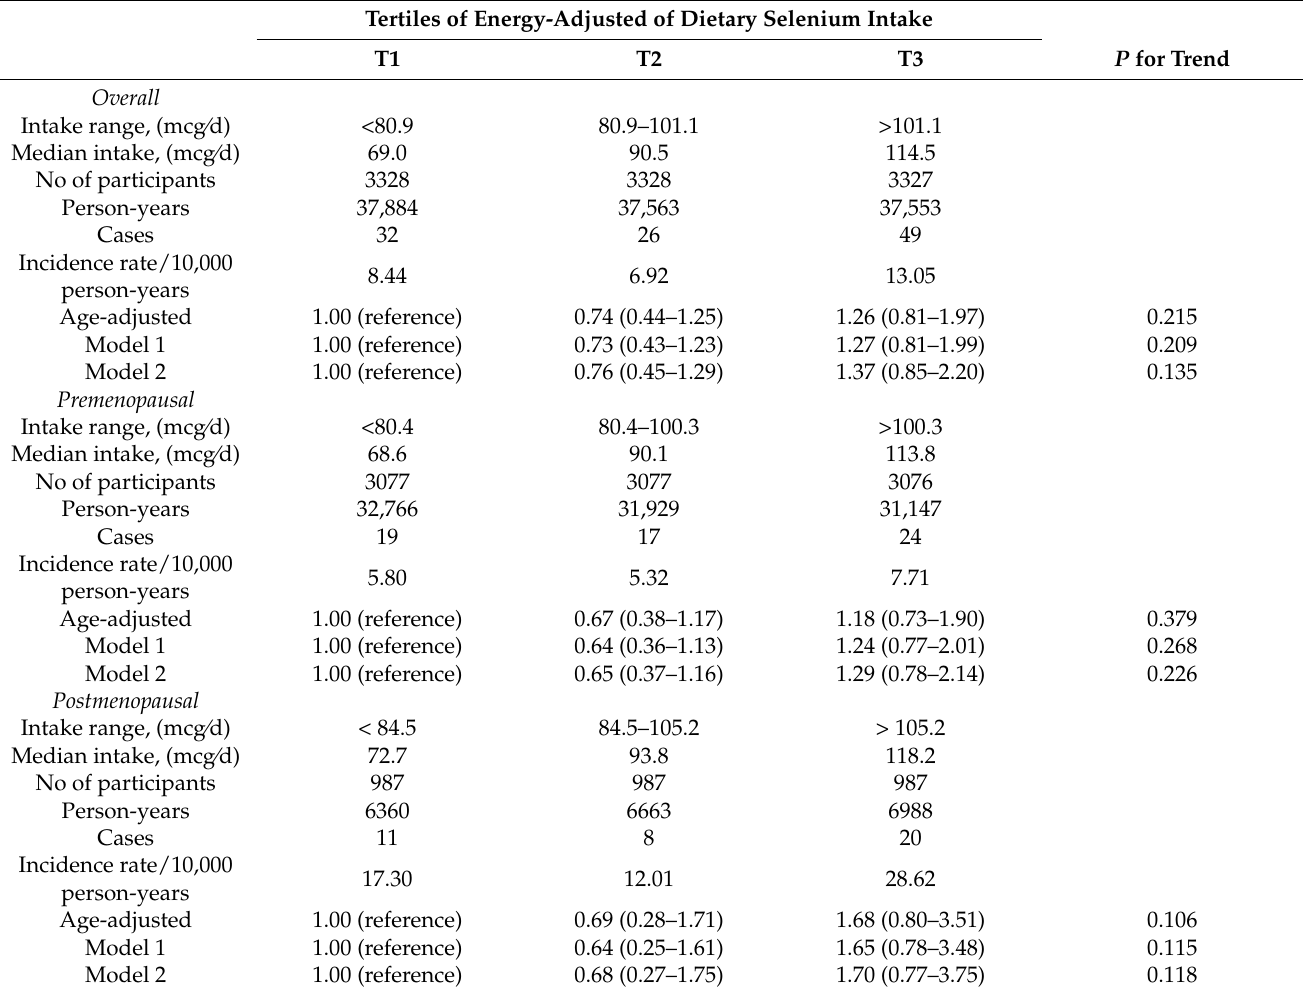
Table 5. Dietary selenium intake. Hazard Ratio (HR) and 95% Confidence Interval (CI) of breast cancer by tertiles of energy-adjusted dietary selenium at baseline among female participants of the SUN cohort. Tertiles of Energy-Adjusted of Dietary Selenium Intake T1 T3 P for